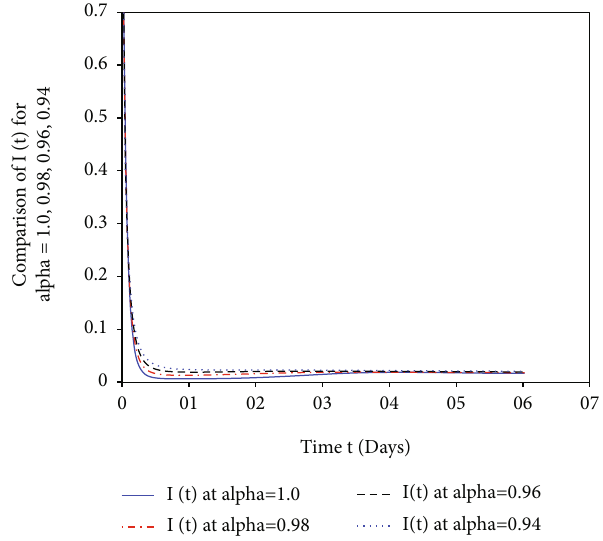
Figure 6: The infected class I ð t Þ for ϱ = 1 : 0, 0 : 98, 0 : 96, 0 : 94 .